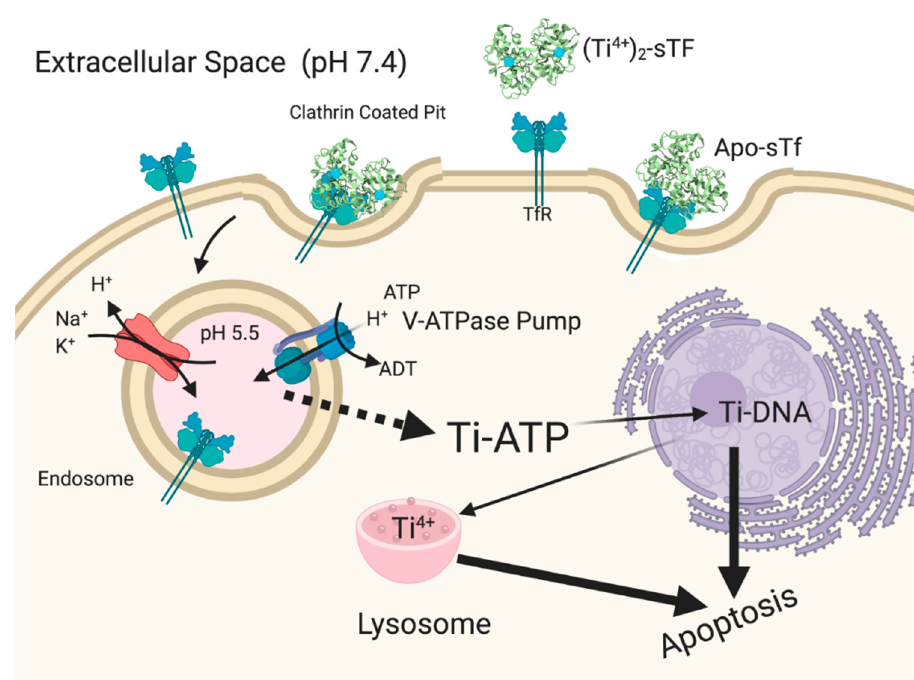
Figure 17. Proposed antiproliferative/cytotoxic mechanism of action of Ti(IV) from a hydrolysis prone compound like Cp 2 TiCl 2 . Created with BioRender.com.